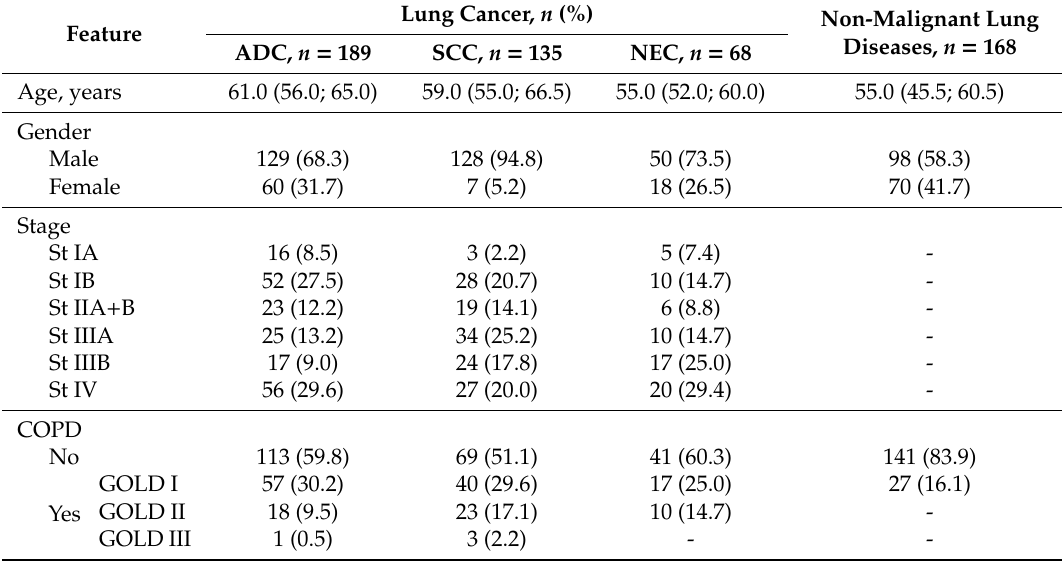
Table 1. The structure of the study